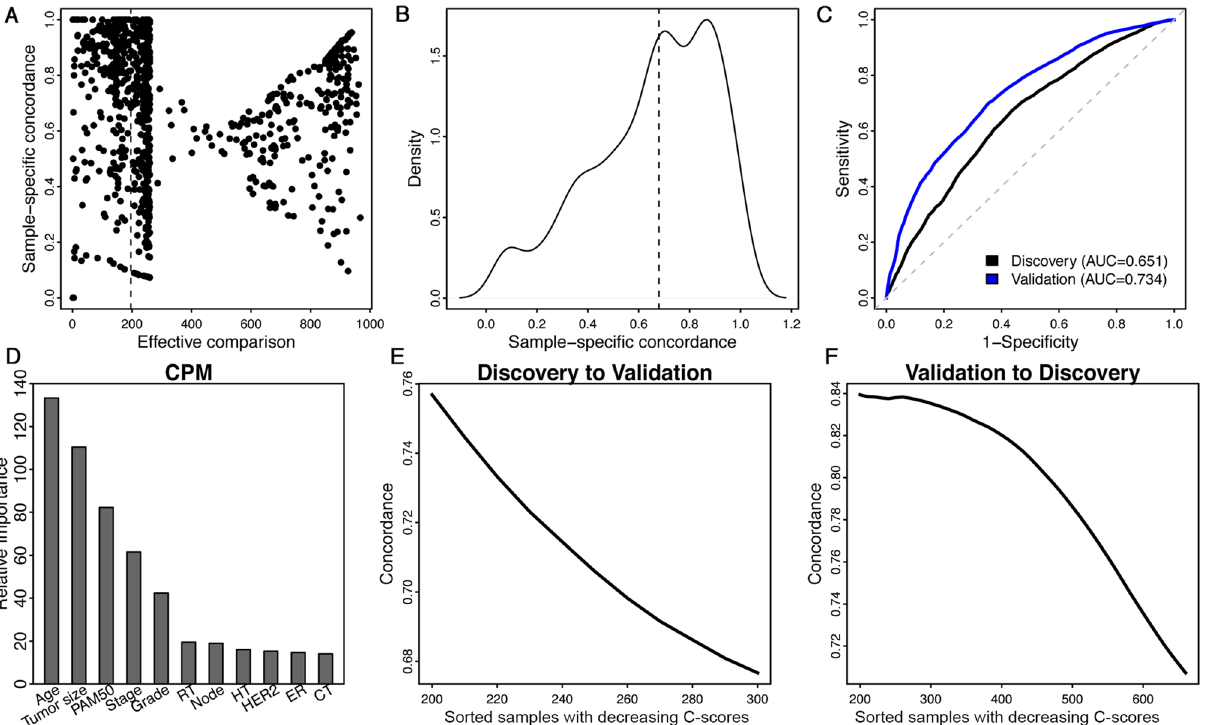
Figure 5. Predicting the recurrence-free survival of patients with breast cancer using the Oncotype DX biomarker. ( A ) Patients vary substantially in their number of effective comparisons and sample-specific concordance scores resulting from the Cox regression model (CPM) using the Oncotype DX score as the single predictor. ( B ) The distribution of sample-specific concordance scores of patients. Results shown in A and B are based on the Curtis discovery data. ( C ) The prediction accuracy of the PPM was estimated from tenfold cross- validation using the Curtis discovery and validation data. ( D ) The relative importance of predictors used in the PPM (discovery data). ( E ) Application of the CPM/PPMs trained from the discovery data to patients in the validation cohort, and ( F ) vice versa. Patients are sorted in the decreasing order of their confidence scores, and the average concordance in the top N patients was calculated from N = 1 to all patients. The curve was smoothed by averaging values within a sliding window of size